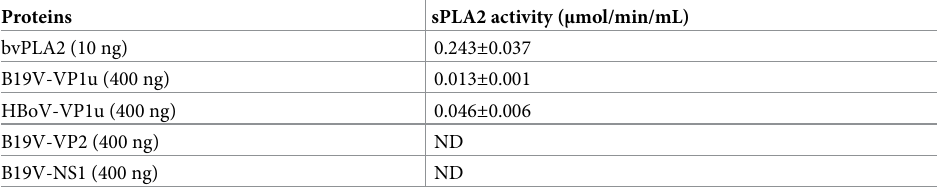
Table 1. Secreted phospholipase A2 (sPLA2) activity of recombinant B19V-VP1u and HBoV-VP1u proteins.